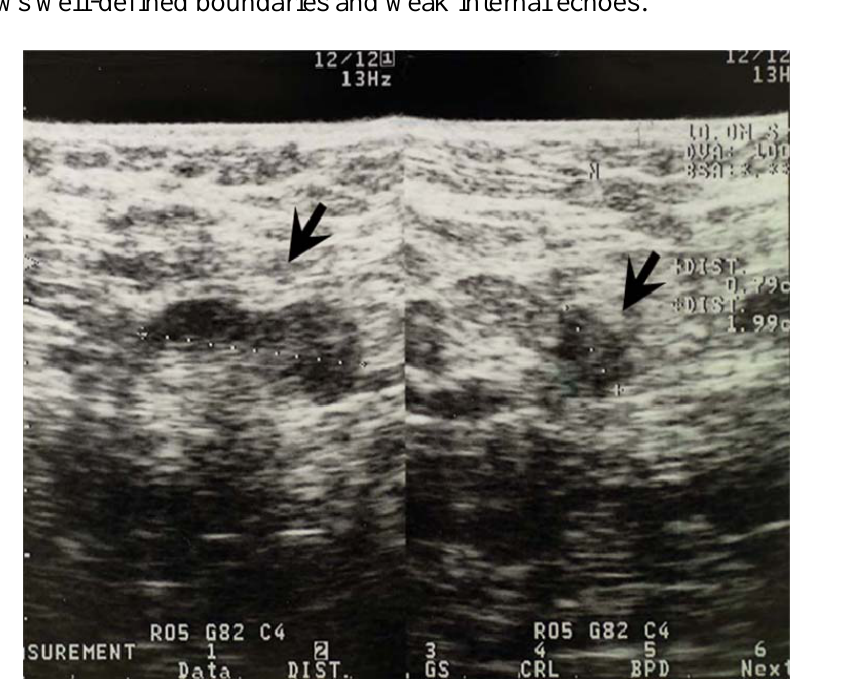
Figure 5. Ultrasonographic appearance of type 2 lymph node metastases. This lymph node (arrow) shows well-defined boundaries and weak internal